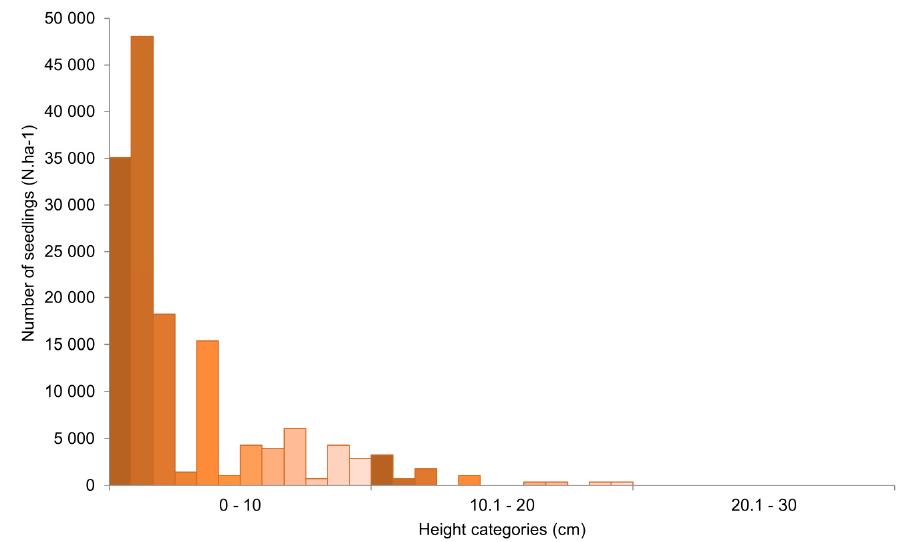
Figure 2. Density of yew natural regeneration according to height categories. Vertical bars represent individual sampling plots.